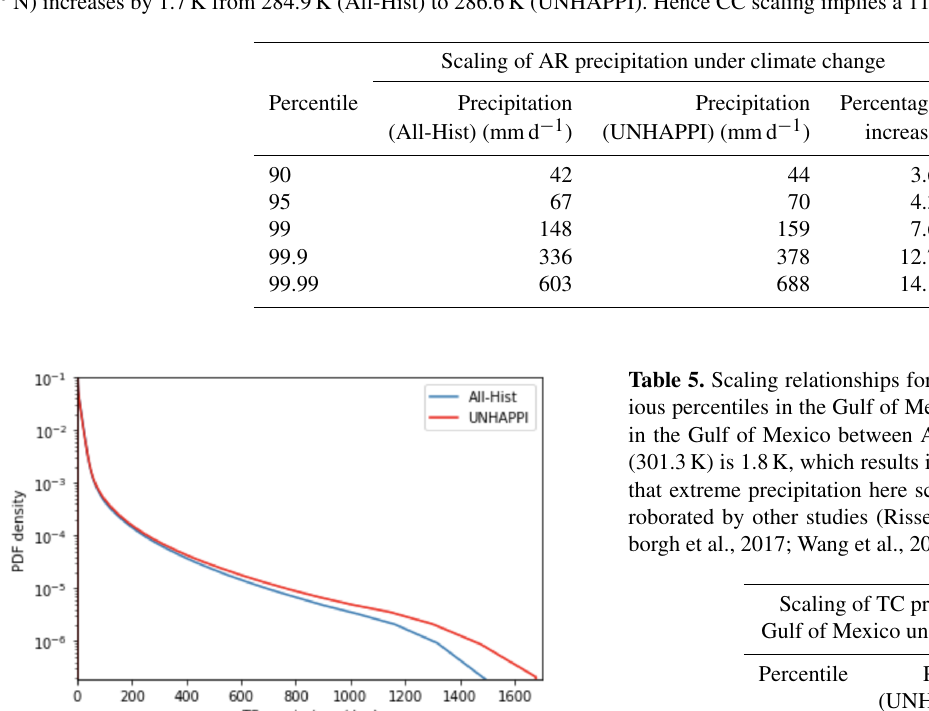
Table 4. Scaling relationships for atmospheric river precipitation at various percentiles for extremes. Note that extreme ARs have more extreme precipitation in a warmer world. The mean SST for regions where ARs are most dominant (mid-latitudes, i.e., 30–60 ◦ S and 30– 60 ◦ N) increases by 1.7K from 284.9K (All-Hist) to 286.6K (UNHAPPI). Hence CC scaling implies a 11.9% increase in precipitation.